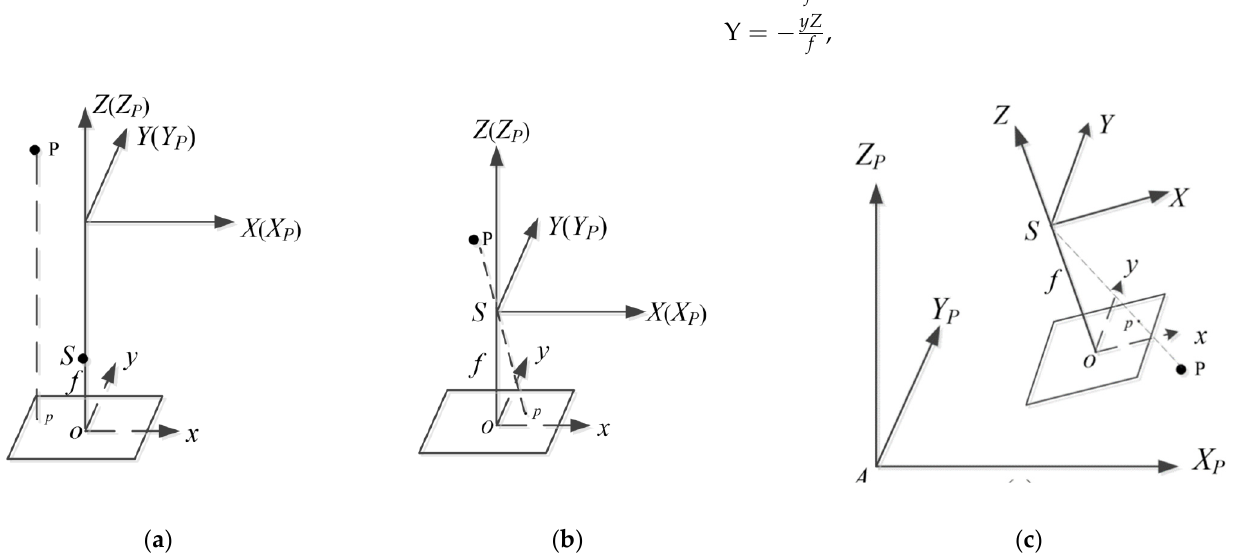
Figure 3. Schematic representation of different imaging conditions ( a ) image and object coordinates for photometric stereo under orthographic projection (PSOP), ( b ) image and object coordinates for photometric stereo under perspective projection with identity matrix (PSPP), ( c ) image and object coordinates for PPS.